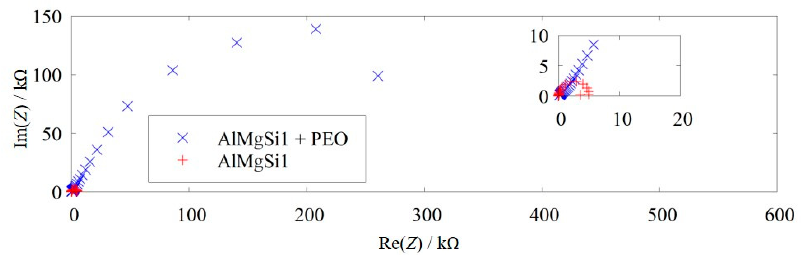
Figure 12. Result of electrochemical impedance spectroscopy of the PEO coating shown in Figure 10 in acidic dilute NaCl solution: The characteristic semicircle in the Nyquist-Plot shows that the resistance against charge transfer (= corrosion reaction) at the electrolyte/substrate interface is increased by the PEO coating.